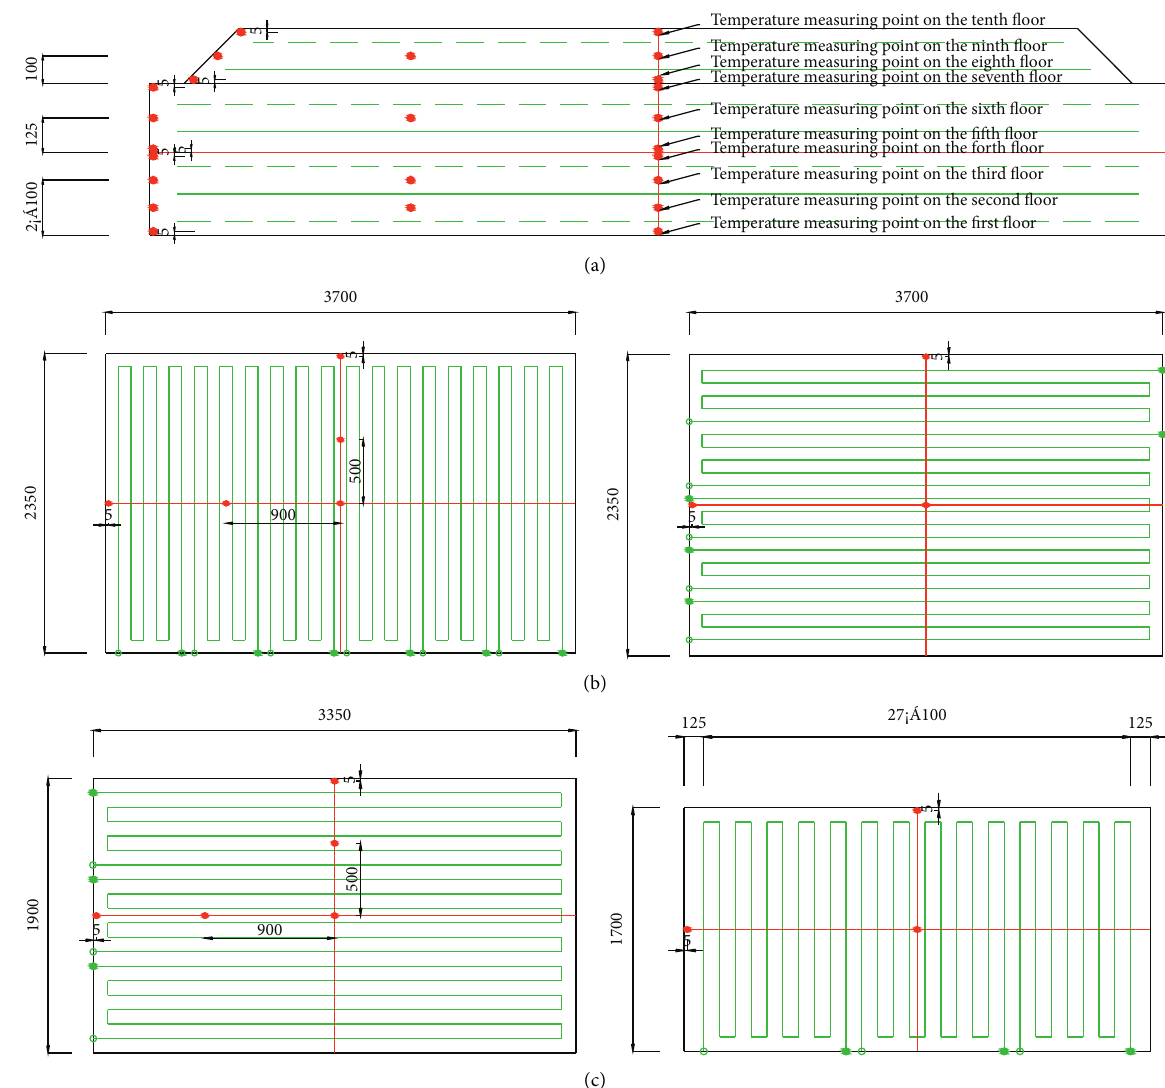
Figure 18: Layout of temperature measuring points. (a) Elevation layout of temperature measuring point of cap. (b) Floor plan of temperature measuring point of cap. (c) Layout of temperature measuring point of